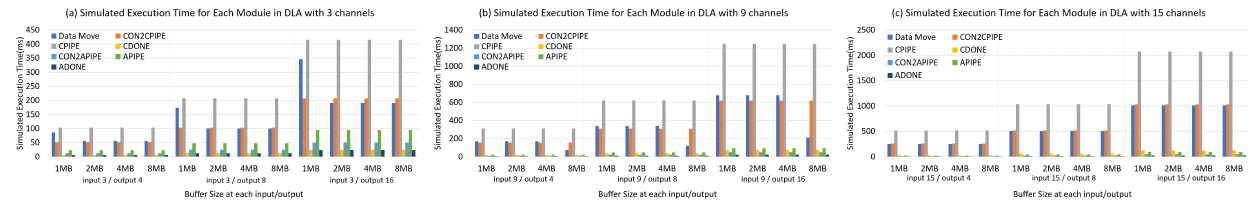
Figure 10. It plots simulated execution times of each submodule in DLA for CNN running with inputs 256, 512, 1024 and outputs 32, 128, 245 for 13 × 13 images and 1 × 1 filter